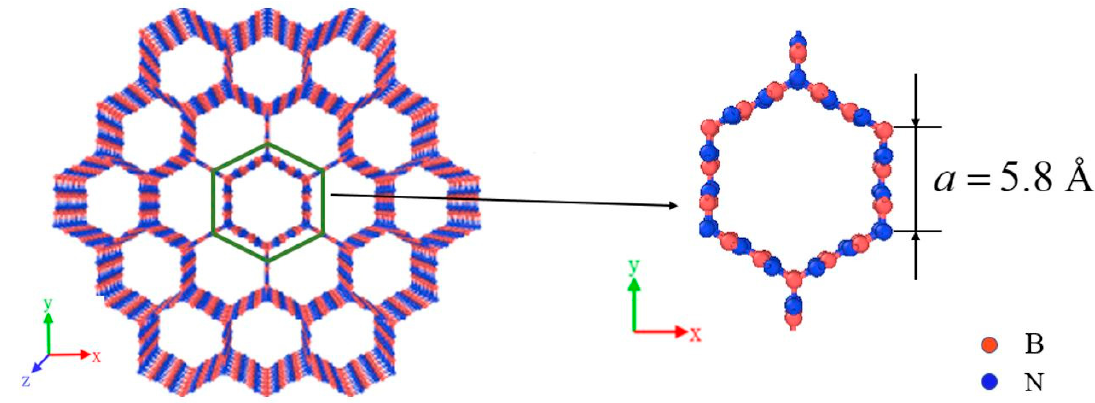
Figure 1. The graphical structure of boron nitride honeycomb.